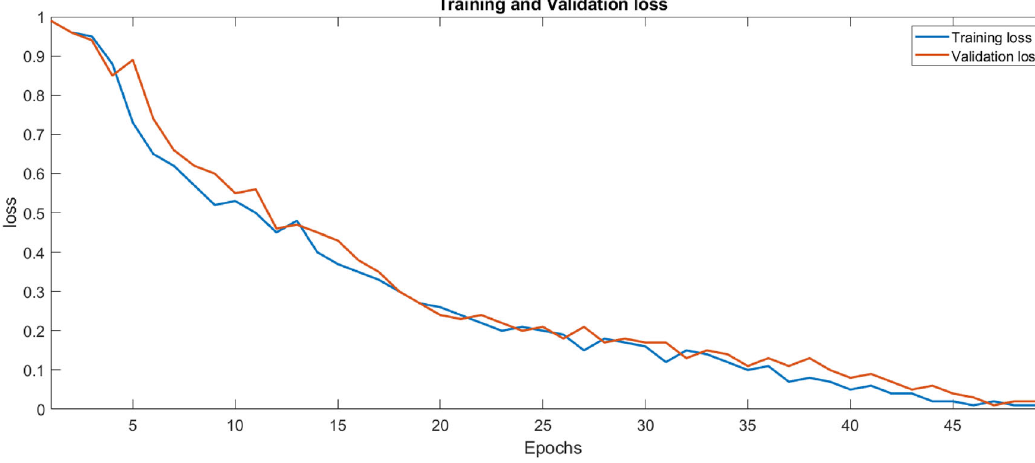
Fig. 7 The analysis of the suggested network using epoch versus